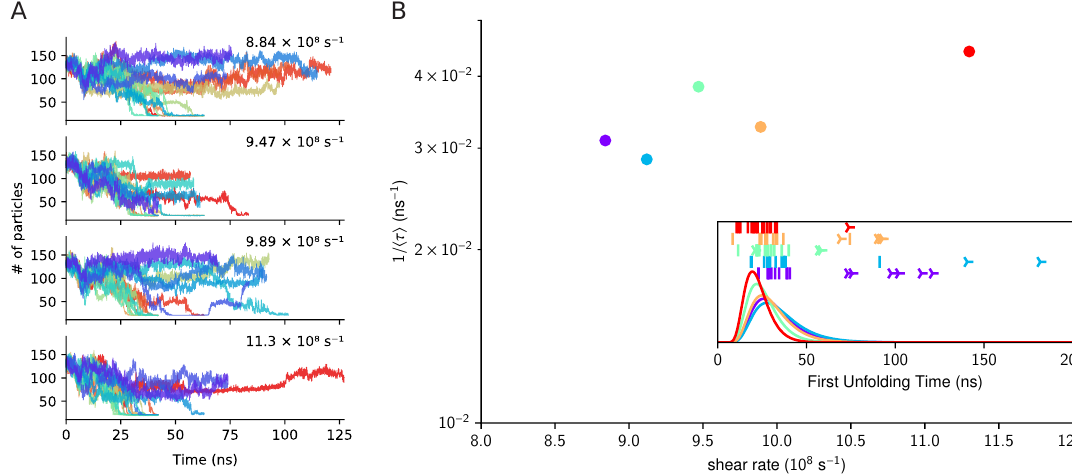
Figure 5. Exposure of cleavage site in A1A2A3 under shear flow. Panel ( A ). Time evolution of the coordination number of the cleavage site in A2 expressed as the number of backbone atoms inside a sphere of radius r c = 10Å centered on 111 Tyr. In the four panels we report data for several shear rates. Panel ( B ). Shear-dependent mean exposure kinetics derived from the estimate of the first unfolding time obtained from maximum likelihood approach (ML). In the inset chart the ML derived distributions for the exposure time are reported for the different shear rates (solid lines) together with the simulated unfolding times (vertical bars) or the end of not-yet-unfolded trajectories (three-pointed